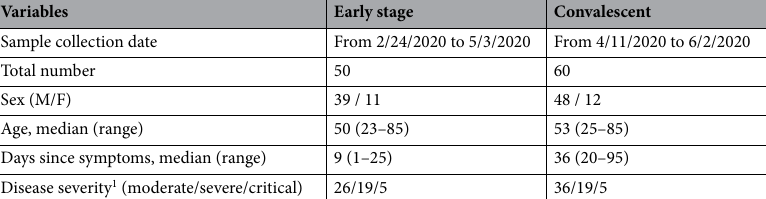
Table 2. Patients and sample collection information. 1 Disease severity definitions—Moderate: febrile or fatigue, and with/without pneumonia, and no oxygen inhalation required; Severe: febrile, fatigue, dyspnea, severe pneumonia identified, and oxygen inhalation required; Critical: febrile, fatigue, severe dyspnea, critical pneumonia identified, and positive pressure ventilation plus extracorporeal membrane oxygenation (ECMO)